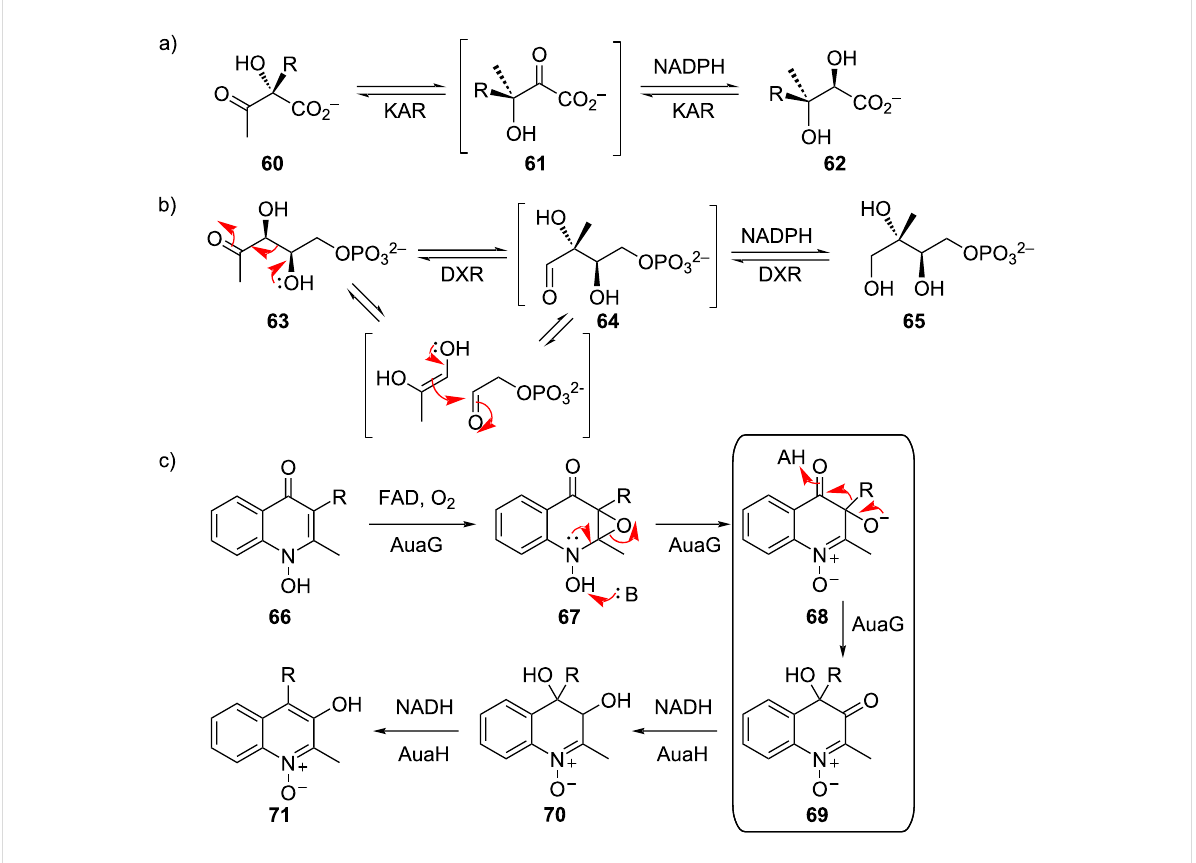
Figure 14: Enzyme-catalyzed α -ketol rearrangements. a) Ketol-acid reductoisomerase (KAR) catalyzes the rearrangement of (2 S )-acetolactate ( 65 , R = Me) or (2 S )-acetohydroxybutyrate ( 65 , R = Et) to 66 , followed by reduction by NADPH to 67 . b) Despite the similarity in reaction, 1-deoxy- ᴅ -xylu- lose-5-phosphate reductoisomerase (DXR) instead uses a retro-aldol/aldol sequence to accomplish its rearrangement of 68 to 69 . c) The secondary metabolite aurachin C ( 71 ) is oxidized by the FAD-dependent monooxygenase AuaG to epoxide 72 , which upon deprotonation by an enzymatic base (B), ring opens and subsequently rearranges to 74 . AuaH uses NADH to reduce the ketone to diol 75 , which undergoes dehydration to give aurachin B ( 76